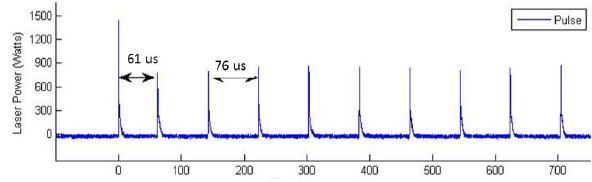
Figure 4: Ten shots pulse profiles and plasma radiation measure-